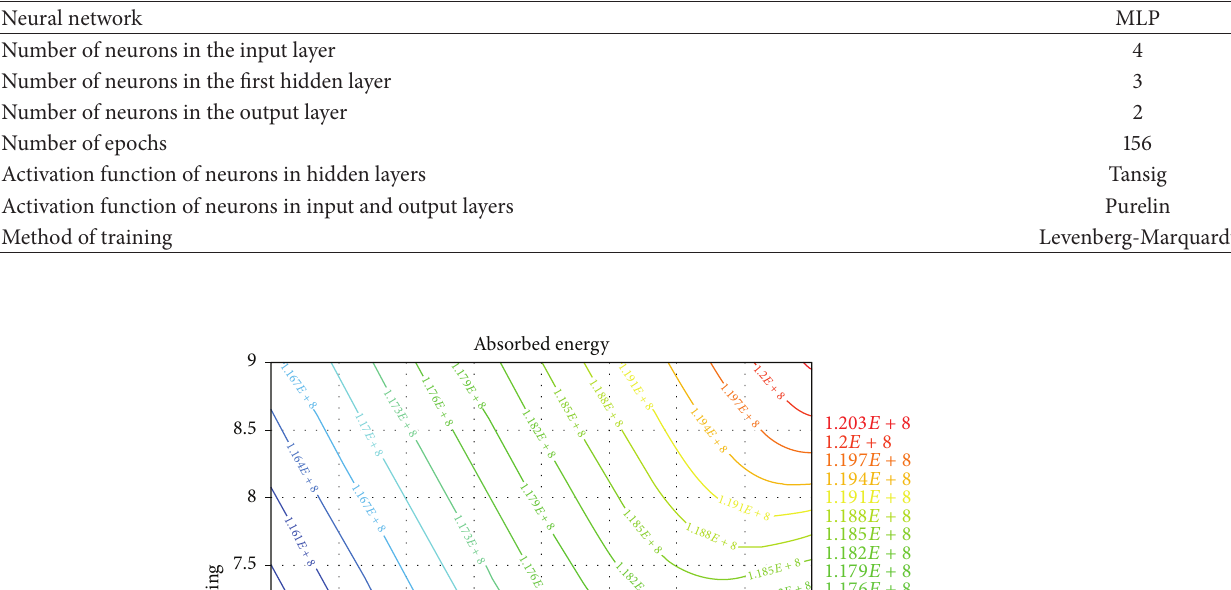
Table 2: Specification of proposed ANN model.